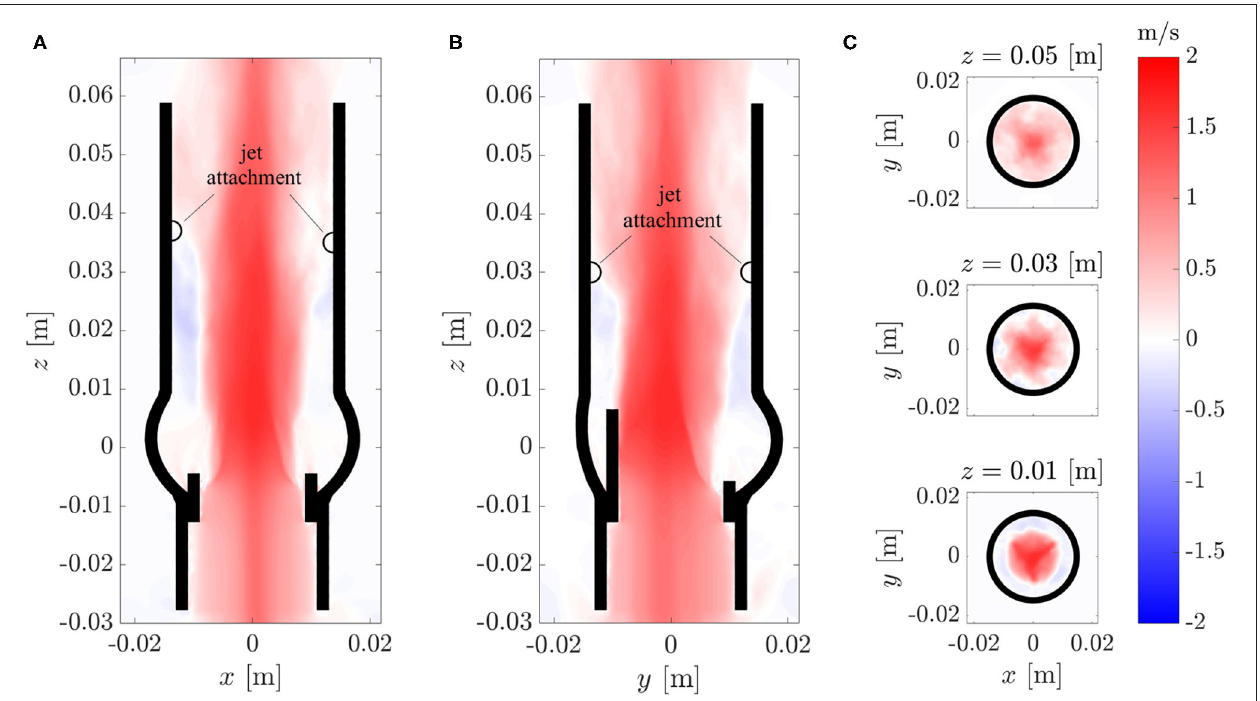
FIGURE 7 | Axial component V z of the mean flow field V f in different cross-sections of the computational domains: (A) xz -plane, (B) yz -plane, (C) xy